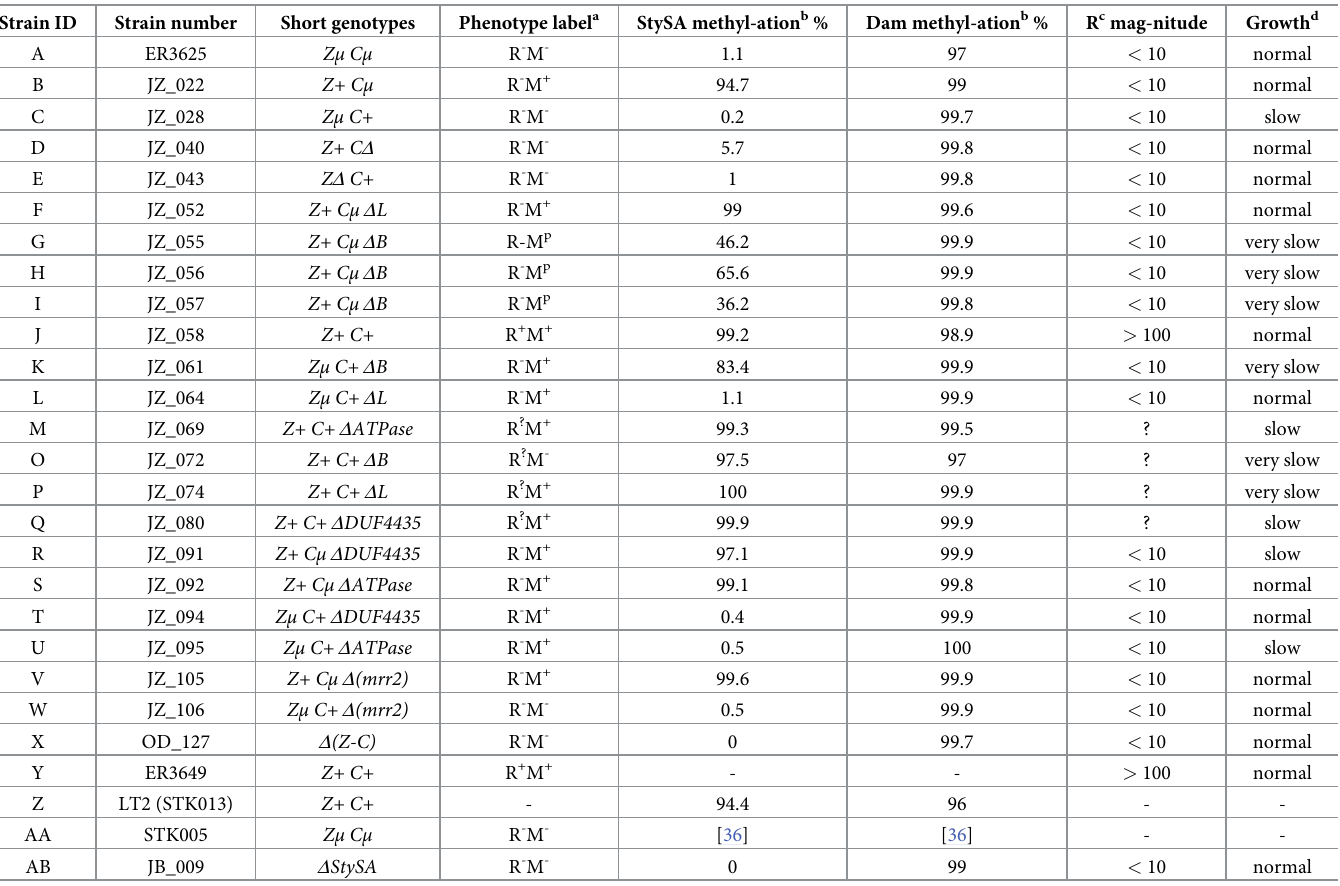
Table 1. Strain names, labels, and phenotype